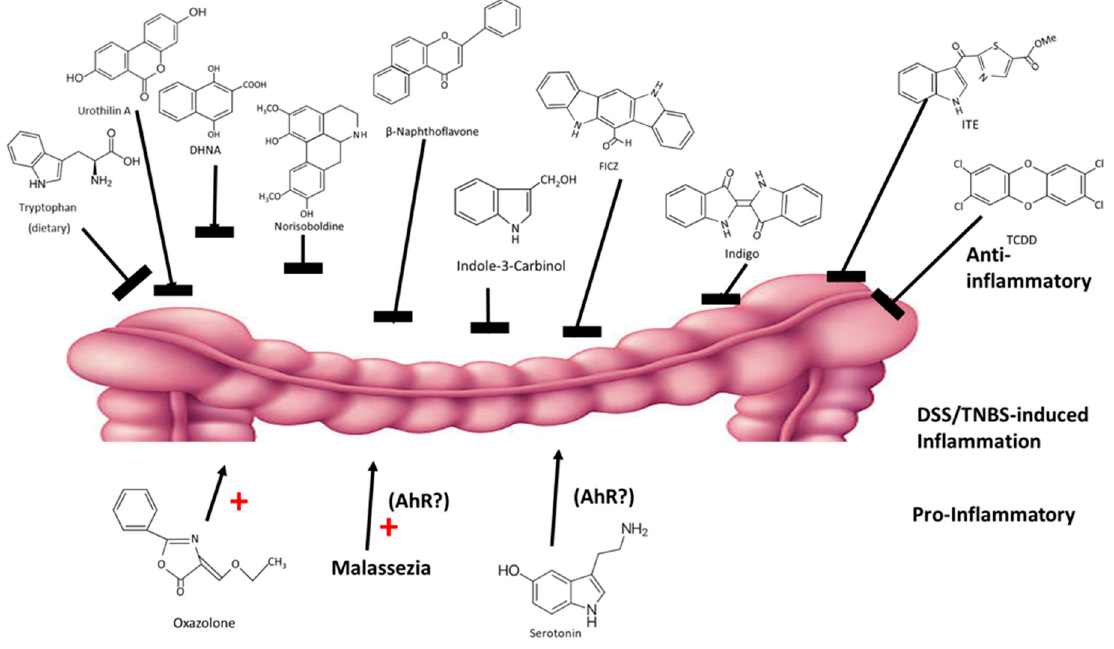
Figure 5. AhR ligands exhibit anti-inflammatory (top) and pro-inflammatory e ff ects in mouse models of intestinal inflammation (rev. in